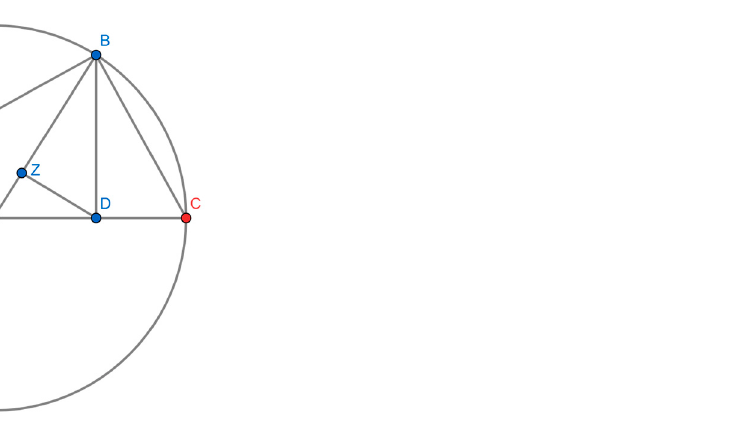
ence. A line BD is dropped to meet AC at a right angle, and DZ is drawn perpendicular to